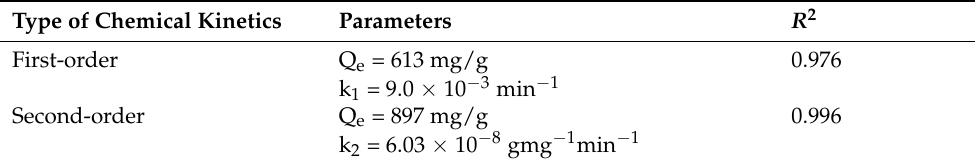
Table 2. Calculated parameters for fitting the chemical kinetics of the Ag/Fe 3 O 4